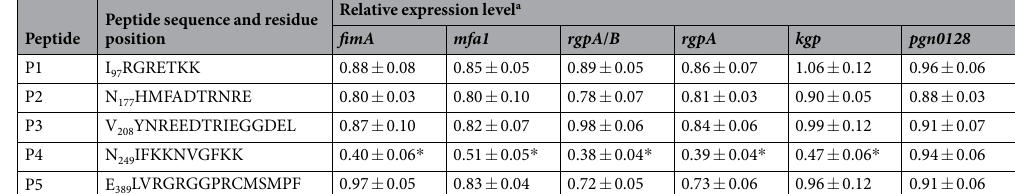
Table 1. Differential expression of virulence genes in P . gingivalis in the presence of ArcA peptides. a P . gingivalis 33277 was grown TSB in the presence or absence of peptide at a concentration 16 µ M. Transcript levels were measured by real-time PCR. The mRNA levels of genes are indicated relative to the expression level in the absence of peptides as 1 unit. Results shown are means and standard deviations from three independent experiments. Asterisks indicate the statistical significance of expression levels at least two fold in P . gingivalis grown in TSB with/without peptides ( P < 0.05; t test).